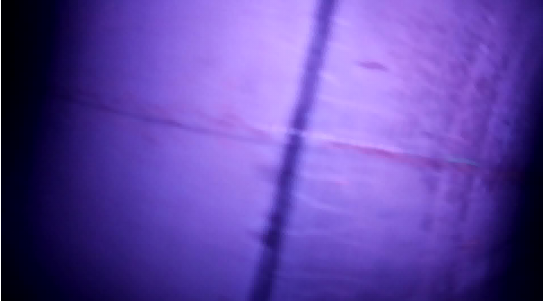
Figure 8. Example of a video frame captured at a pipe segment joint.